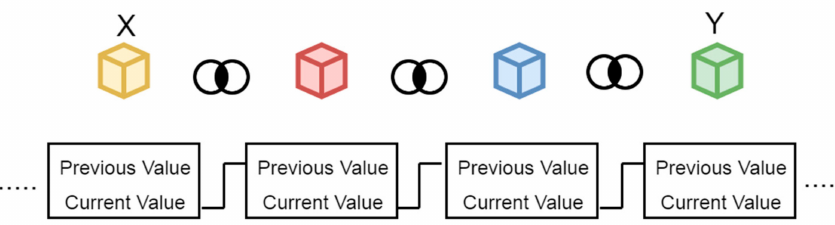
Figure 6. The blockchain among sender and